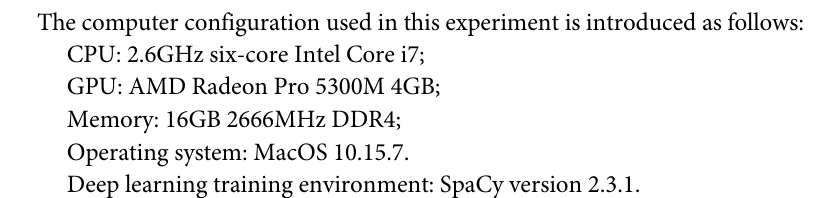
PLOS ONE | https://doi.org/10.1371/journal.pone.0275872 October 12,